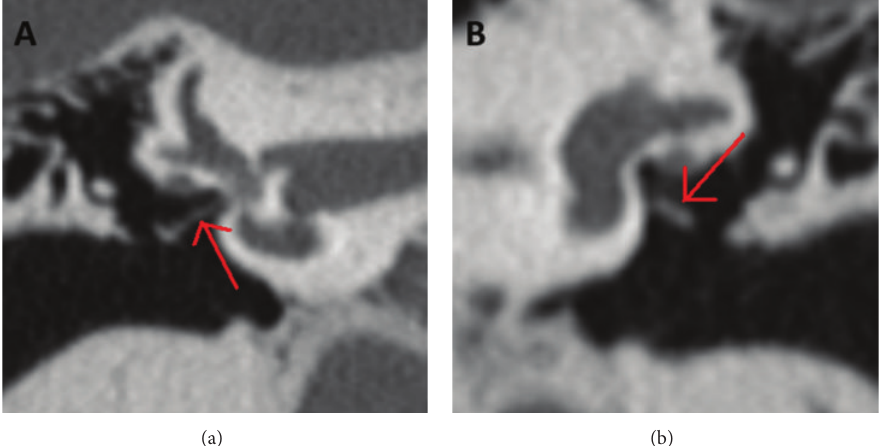
Figure 2: (a) Coronal section of CT showing normal position of stapes and tympanic portion of facial nerve on the right ear. (b) Coronal section of CT showing dislocation of stapes suprastructure from footplate on the left